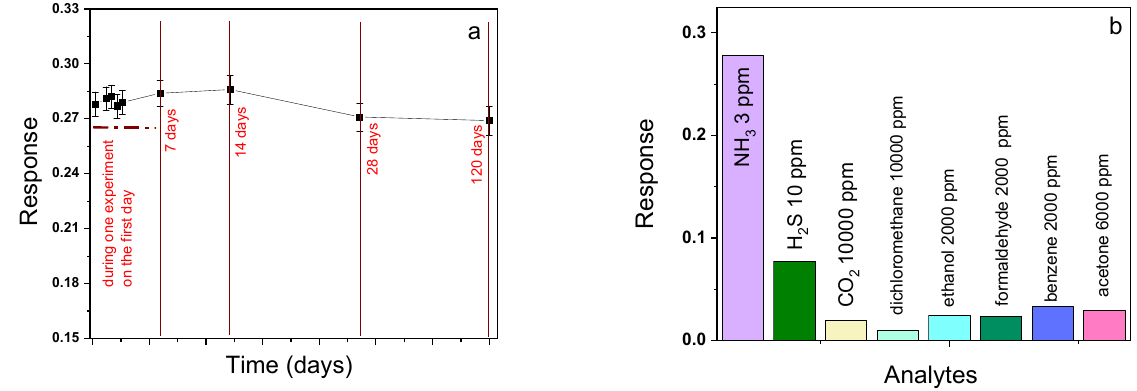
Figure 13. ( a ) Sensor response of a CoPcF 4 -p film to ammonia (3 ppm) after 7, 14, 28, and 120 days. ( b ) Diagram of sensitivity of a CoPcF 4 -p film to various gaseous analytes and volatile organic vapors.